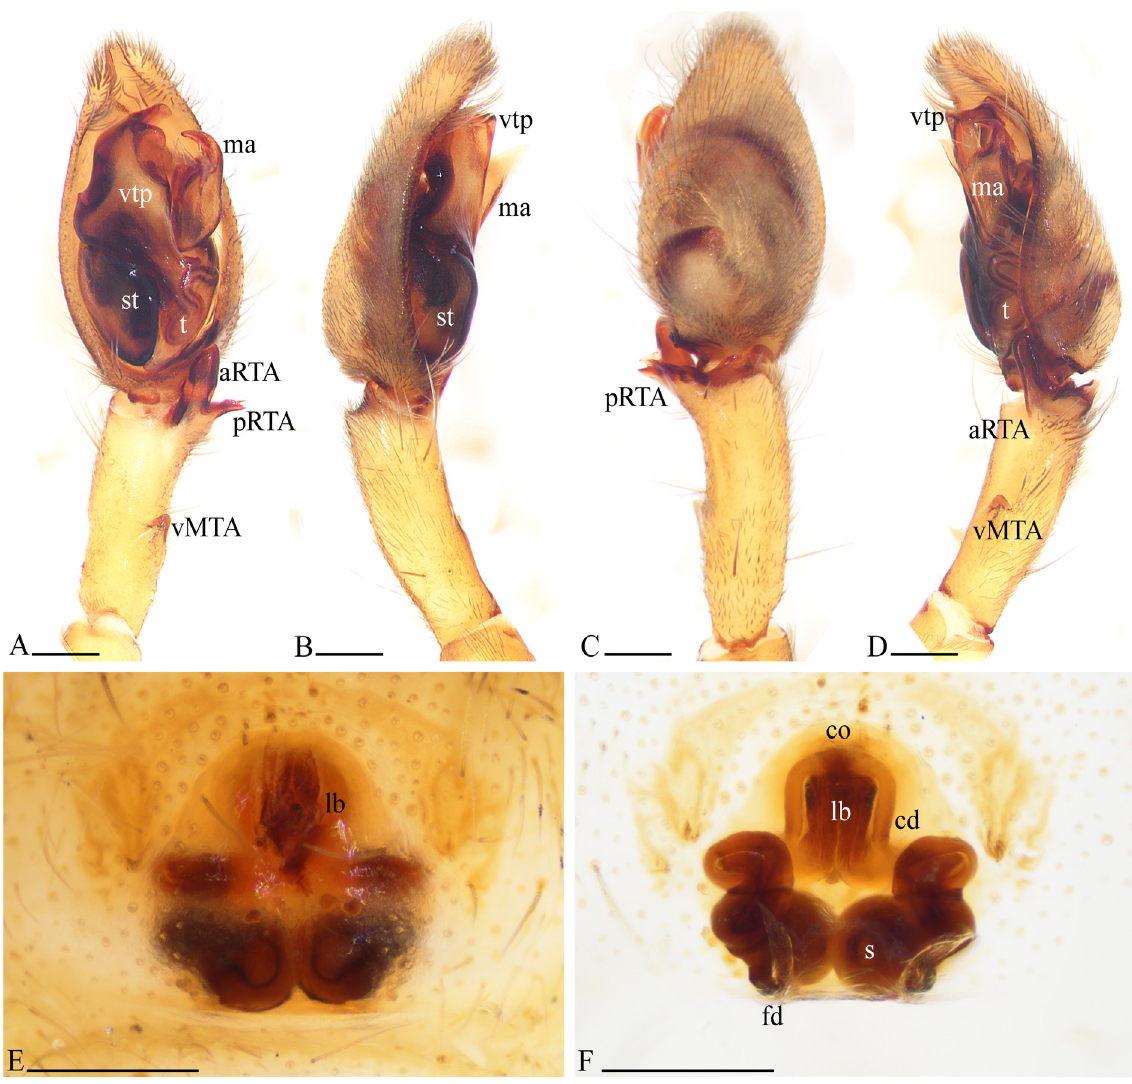
Fig. 46. Anyphaena tonoi sp. nov. A–D . Paratype, ♂ (CNAN-T01575). E–F . Paratype, ♀ (CNAN-T01576). A . Pedipalp, ventral view. B . Pedipalp, prolateral view. C . Pedipalp, dorsal view. D . Pedipalp, retrolateral view. E . Epigynum, ventral view. F . Epigynum, dorsal view. Scale bars: 0.2